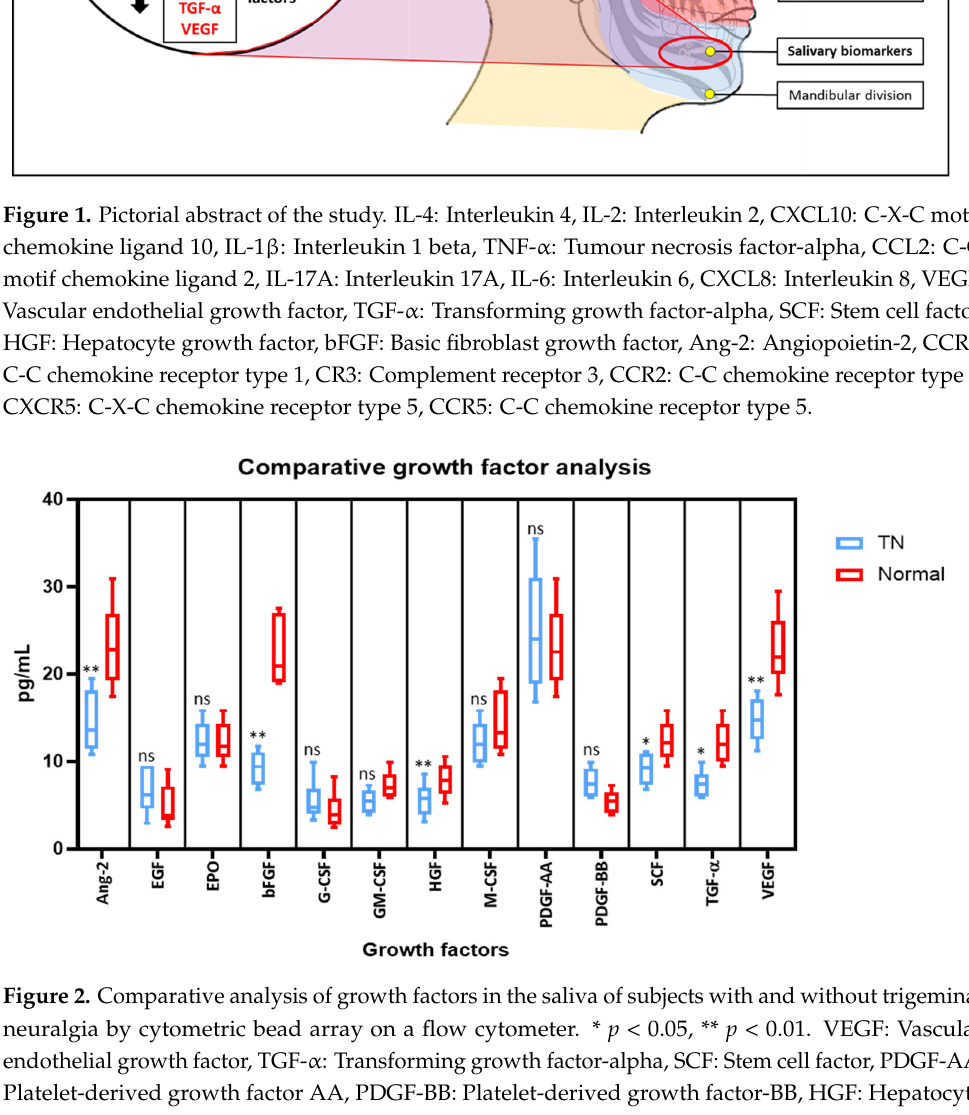
Figure 1. Pictorial abstract of the study. IL-4: Interleukin 4, IL-2: Interleukin 2, CXCL10: C-X-C motif chemokine ligand 10, IL-1 β : Interleukin 1 beta, TNF- α : Tumour necrosis factor-alpha, CCL2: C-C motif chemokine ligand 2, IL-17A: Interleukin 17A, IL-6: Interleukin 6, CXCL8: Interleukin 8, VEGF: Vascular endothelial growth factor, TGF- α : Transforming growth factor-alpha, SCF: Stem cell factor, HGF: Hepatocyte growth factor, bFGF: Basic fibroblast growth factor, Ang-2: Angio- poietin-2, CCR1: C-C chemokine receptor type 1, CR3: Complement receptor 3, CCR2: C-C chemokine receptor type 2, CXCR5: C-X-C chemokine receptor type 5, CCR5: C-C chemokine receptor type 5.